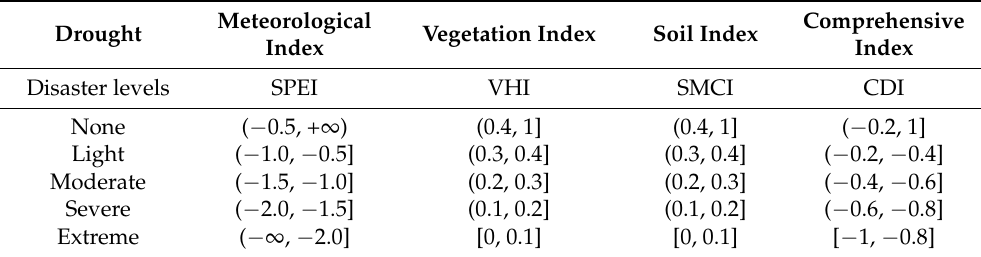
Table 2. Classification of drought disaster